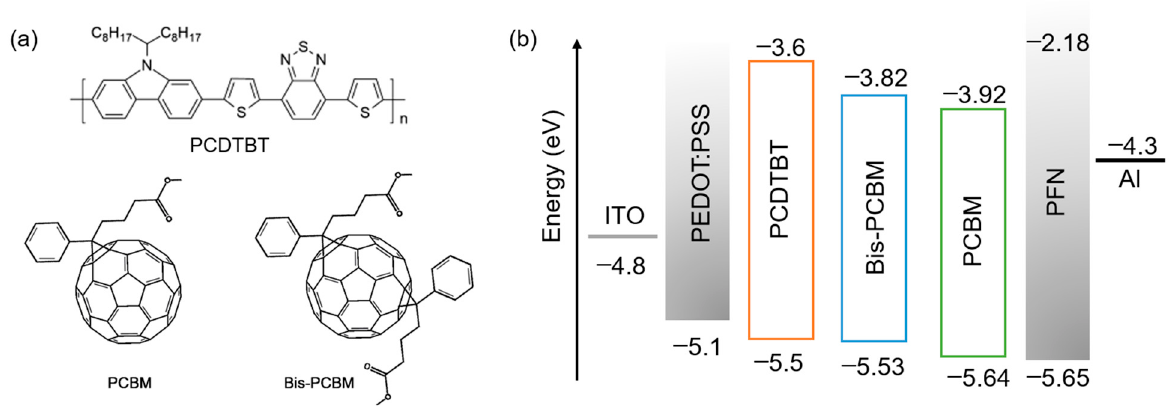
Figure 1. The chemical structure ( a ) and energy band diagram ( b ) of the polymer PCDTBT and fullerene acceptor PCBM and bis-PCBM. The chemical structure of bis-PCBM is a general one without considering its multi-isomers with the second side chain at di ff erent positions.